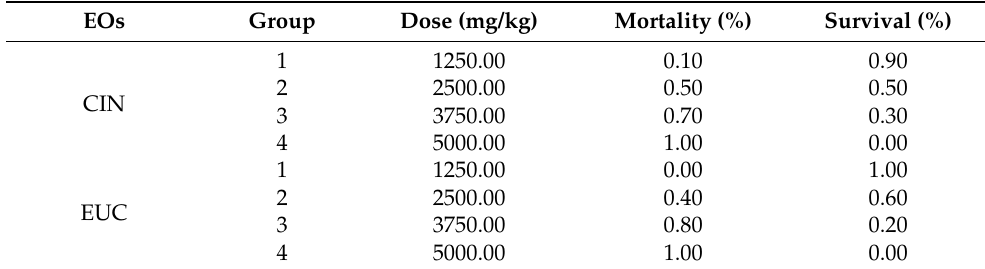
Table 1. Acute oral toxicity of EOs in